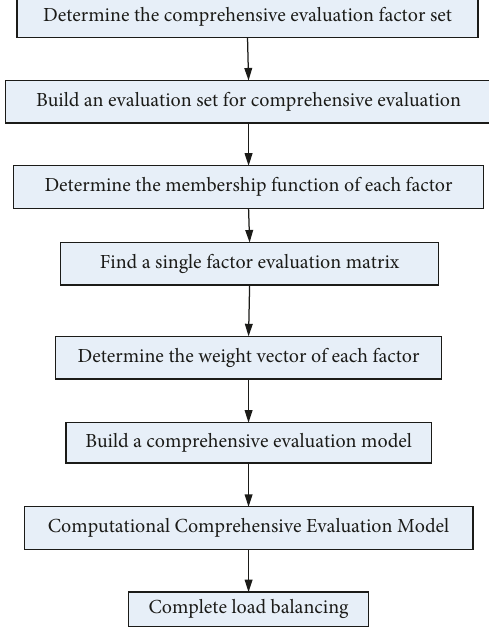
Figure 5: Fuzzy comprehensive evaluation